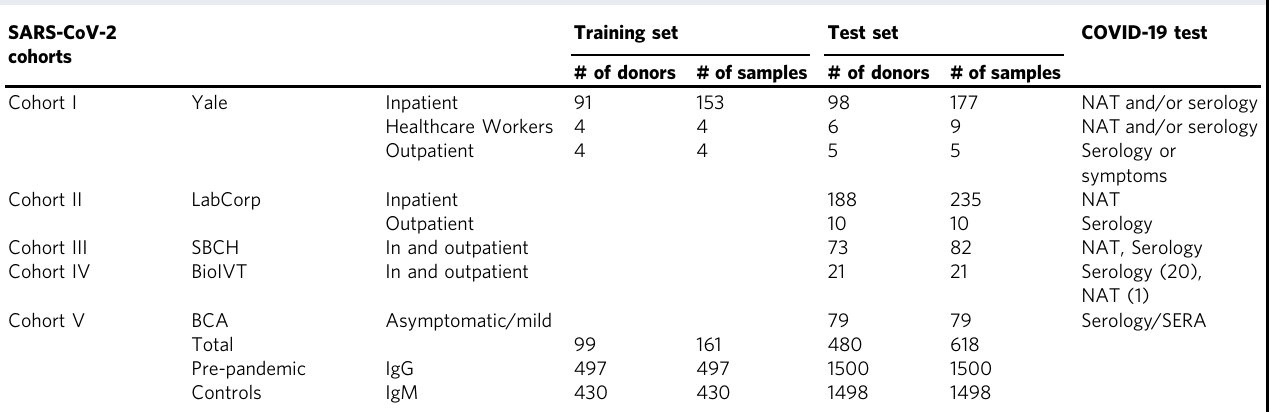
Table 1 SARS-CoV-2 cohorts used for epitope motif